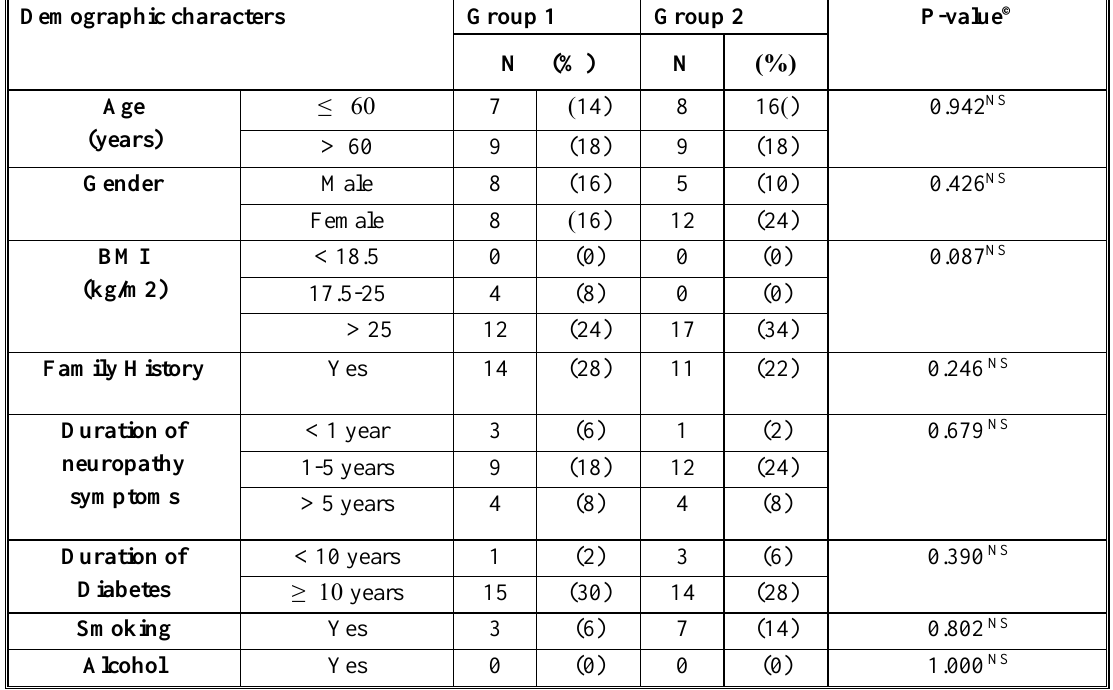
Table 1 .Demographic characteristics of patients with diabetic neuropathy.